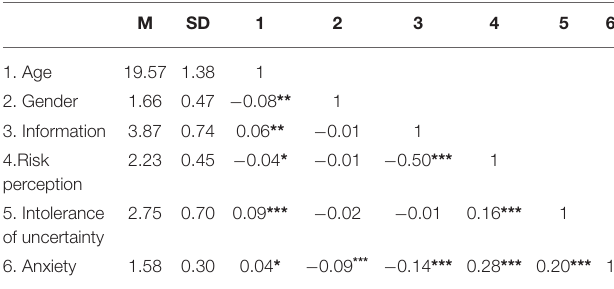
TABLE 1 | Means, standard deviations, and correlations of the main study